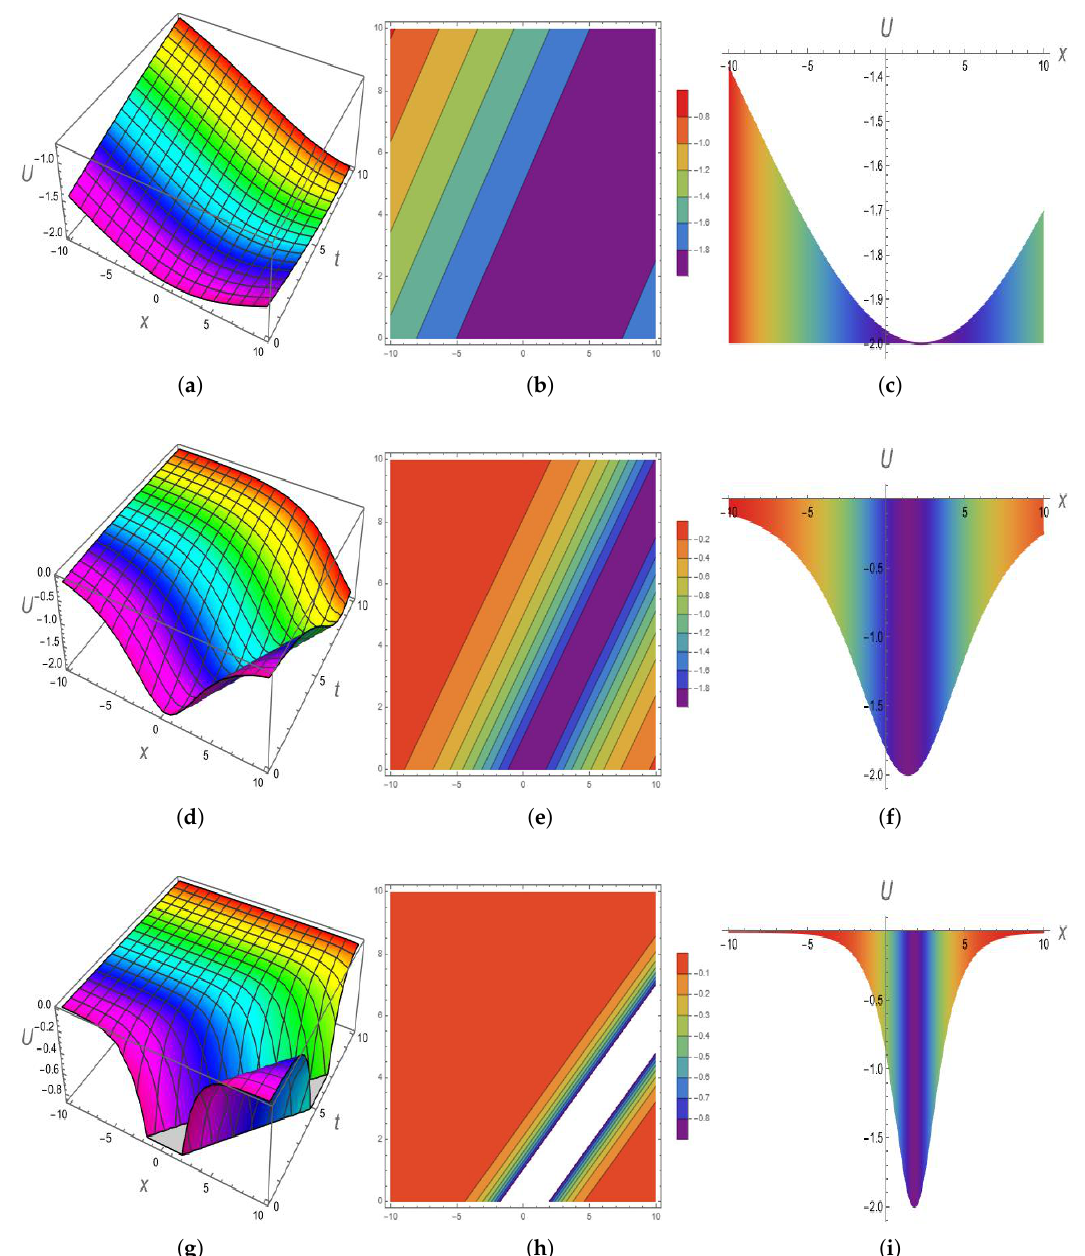
Figure 6. Three-dimensional, contour, and 2-D profiles for the imaginary part of solution £ 18 for different values of parameter k . ( a ) Three-dimensional propagation at k = 0.3; ( b ) Contour propaga- tion at k = 0.3; ( c ) Two-dimensional propagation at k = 0.3; ( d ) Three-dimensional propagation at k = 1.3; ( e ) Contour propagation at k = 1.3; ( f ) Two-dimensional propagation at k = 1.3; ( g ) Three- dimensional propagation at k = 3.3; ( h ) Contour propagation at k = 3.3; ( i ) Two-dimensional propagation at k =